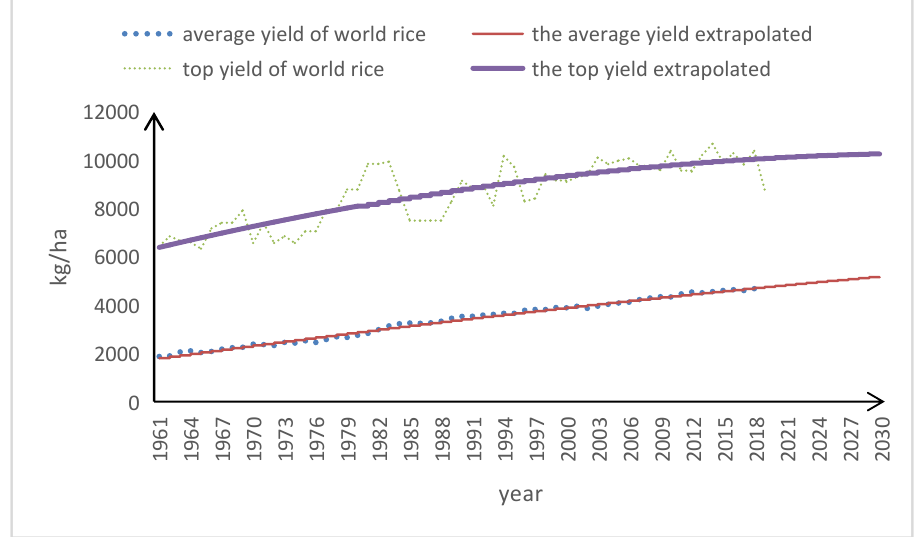
Figure 4. Average and top yields of world rice from 1961 to 2020 and up to 2030.